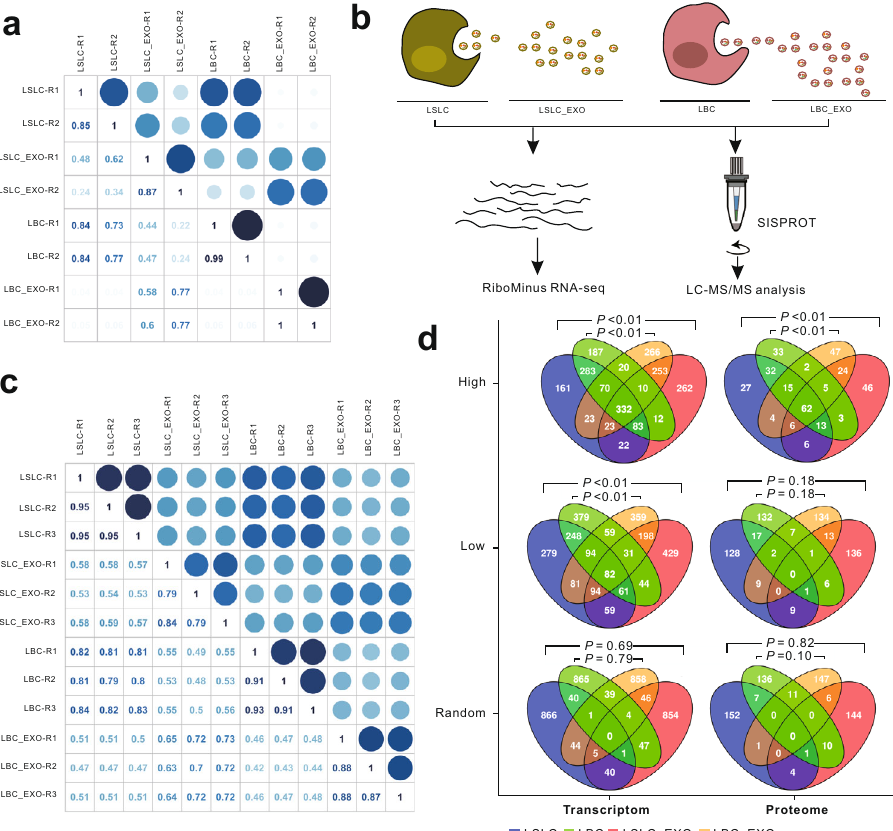
Fig. 5 The correlation analysis of cellular and exosomal RNAs and proteins. a The protein-coding gene expression correlation matrix based on transcriptomic data of all samples. Color intensity and the size of the circle are proportional to the Pearson correlation coef fi cients. b Scheme of the transcriptomic and proteomic data generation. c The gene expression correlation matrix based on proteomic data of all samples. d Venn diagrams depict the overlap of protein-coding genes (left panel) and proteins (right panel) among LSLC, LSLC-EXO, LBC, and LBC-EXO samples. P values were calculated by hypergeometric